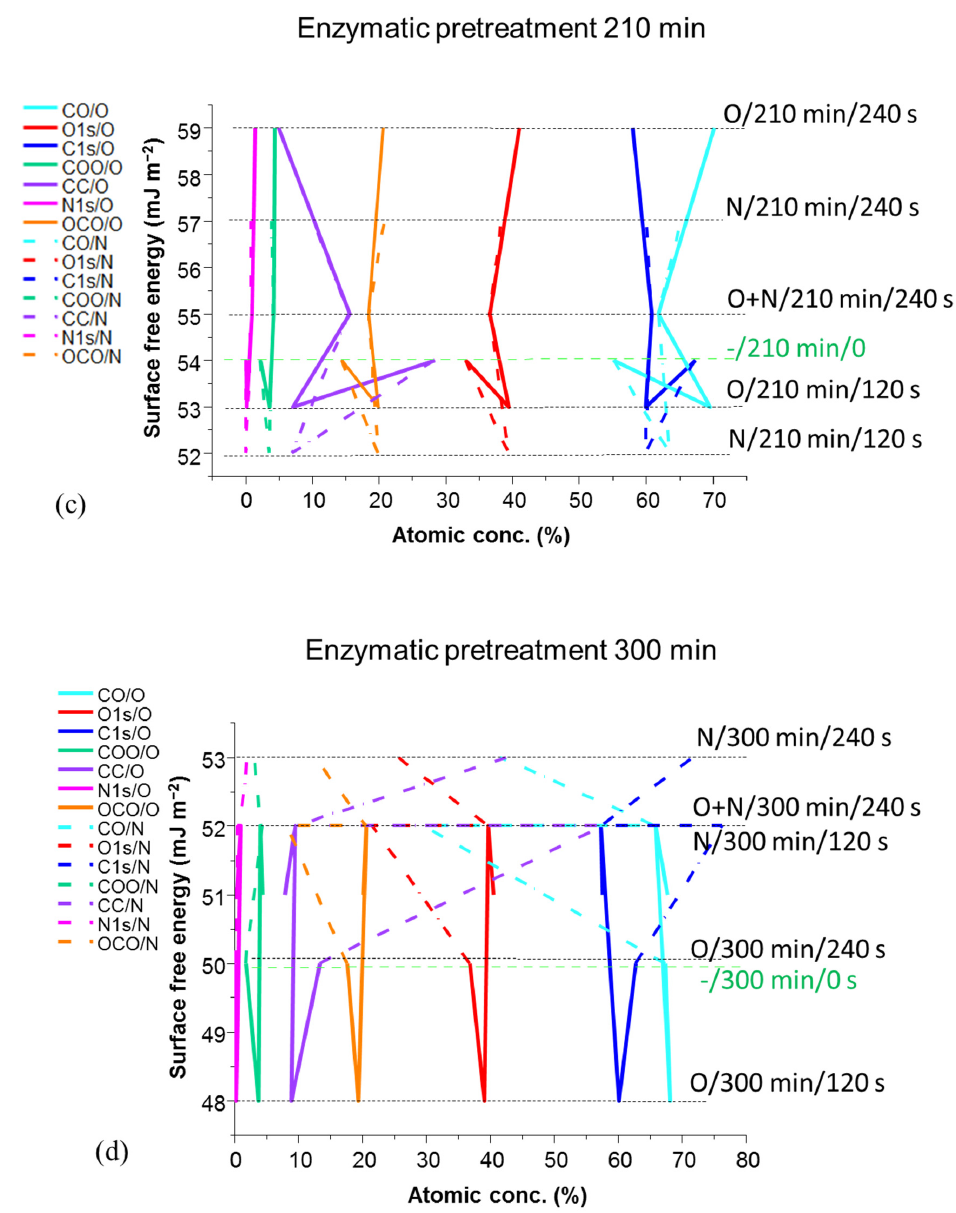
Figure 18. Influence of the O and N plasma exposure on the variously enzymatically pretreated MNFC-derived films by change of chemical properties and accompanying change in effective SFE caused by both induced microroughness and change in atomic concentration at the film surface: ( a ) no enzymatic pretreatment, ( b ) 150 min, ( c ) 210 min, and ( d ) 300 min enzymatic pretreatment, respectively. The joining lines indicate the evolution in SFE as the action of the plasma changes the average atomic moiety concentration, and the data are distributed according to the sample enzymatic pretreatment and plasma exposure histories, with each labelled sample explored marked via the horizontal dotted line recording its given SFE.